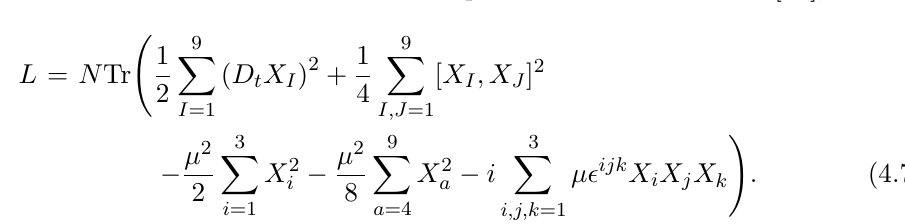
q (cid:20) cos (cid:18) (cid:0) sin 2 (cid:18) with (cid:20) = 1 : (cid:25)(cid:20) 2 2 2